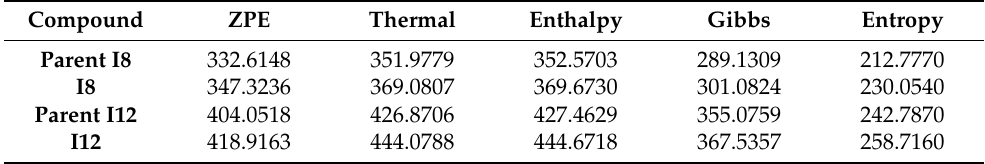
Table 4. Zero-point energy, thermal energy, and the thermodynamic parameters calculated at B3LYP/6-31g